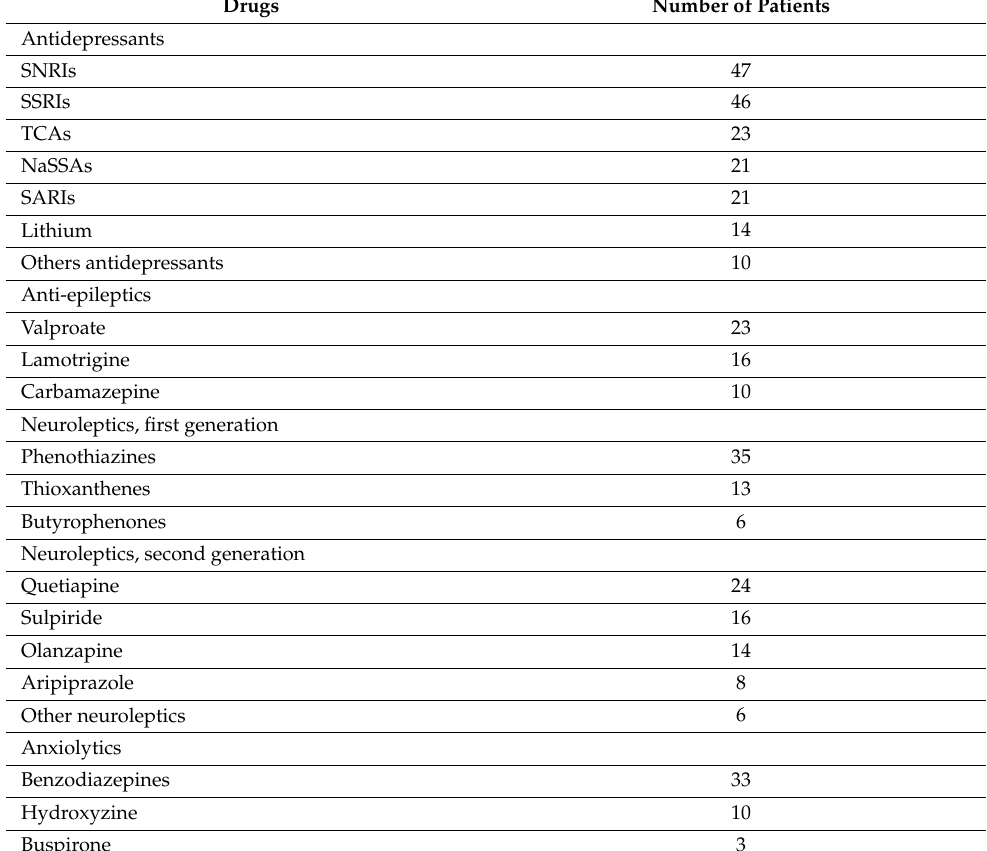
Table 2. Drugs taken by the included patients. SNRIs—serotonin norepinephrine reuptake inhibitors; SSRIs—selective serotonin reuptake inhibitors; TCAs—tricyclic antidepressants; NaSSAs—noradrenergic and specific serotonergic antidepressants; SARIs—serotonin antagonist and reuptake